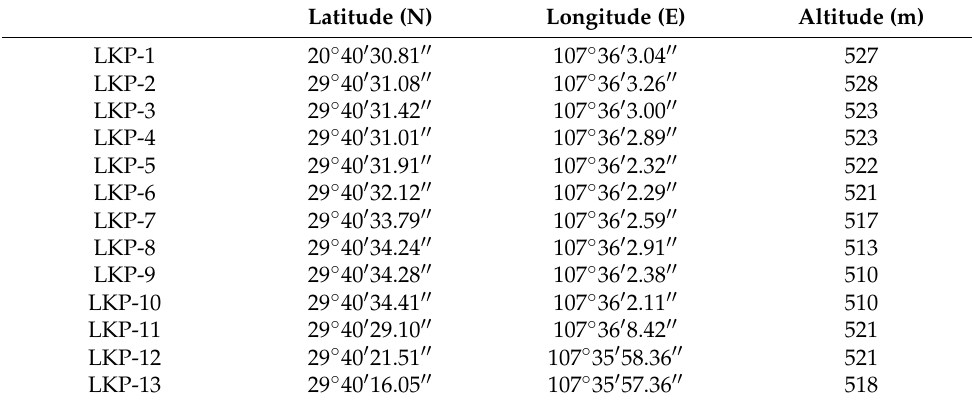
Table 1. The coordinates and altitude in the leakage